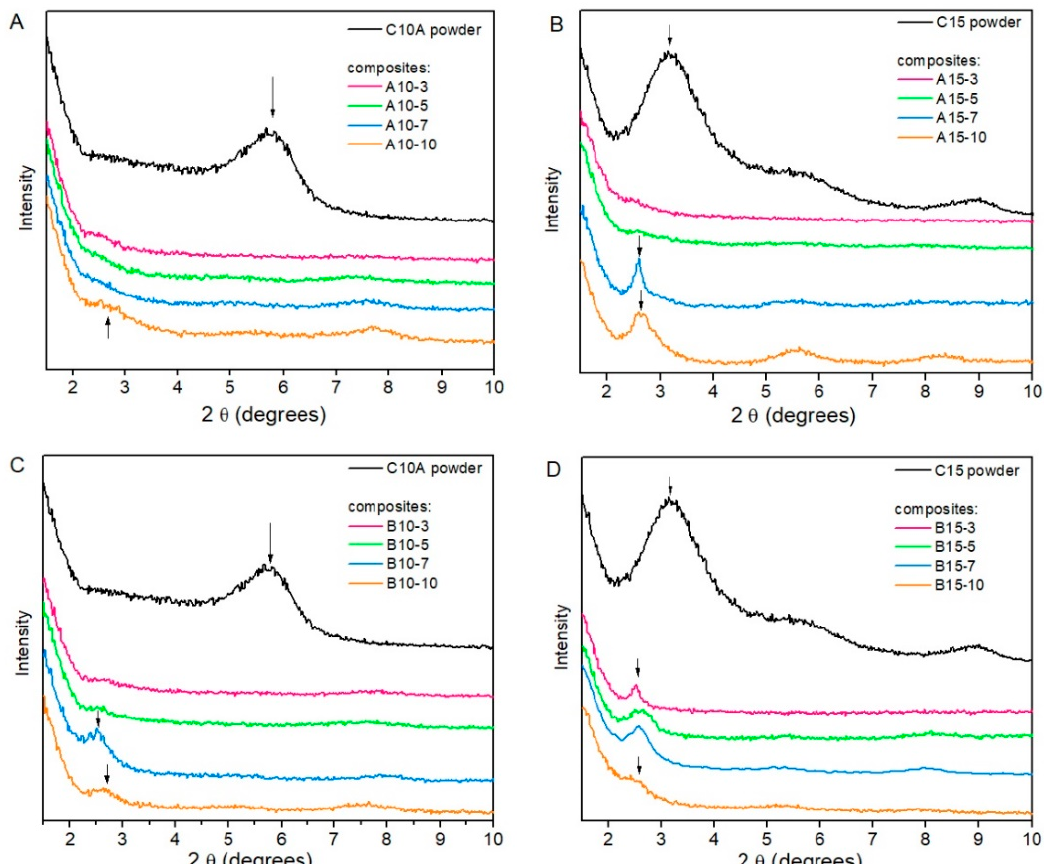
Figure 1. X-ray diffraction patterns of ( A ) Cloisite ® 10A powder (C10A) and rubber nanocomposites with C10A. ( B ) Rubber nanocomposites with CB and C10A. ( C ). Cloisite ® 15 powder (C15) and rubber nanocomposites with C15. ( D ). Rubber nanocomposites with CB and C15.